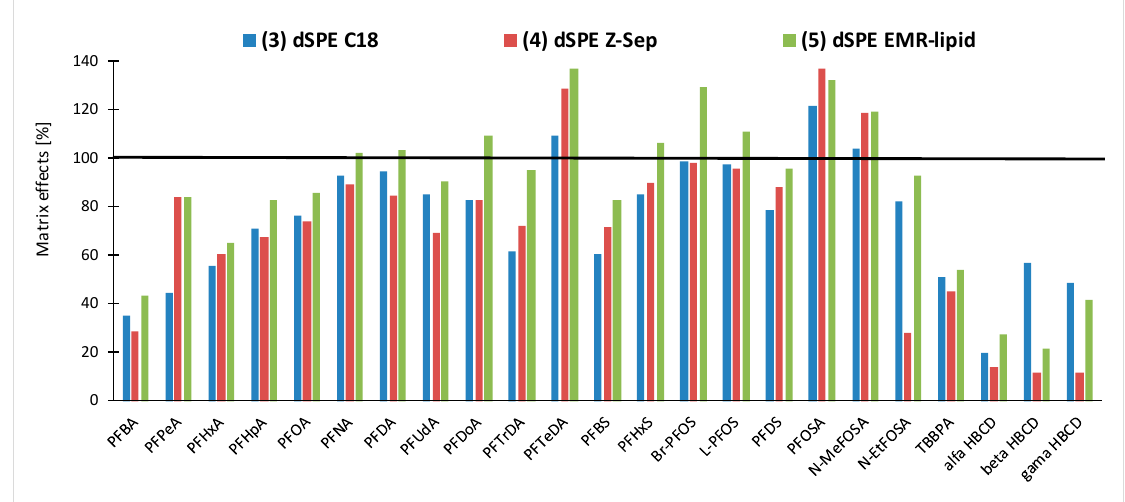
Figure 5. Matrix effects using the tested sorbents (C18, Z-Sep and EMR-lipid) on LC-MS/MS. Response 100% = no matrix effect; response < 100% = signal suppression (e.g., response 40% corresponds to 60% suppression of signal by matrix effects); and response > 100% = signal enhancement.